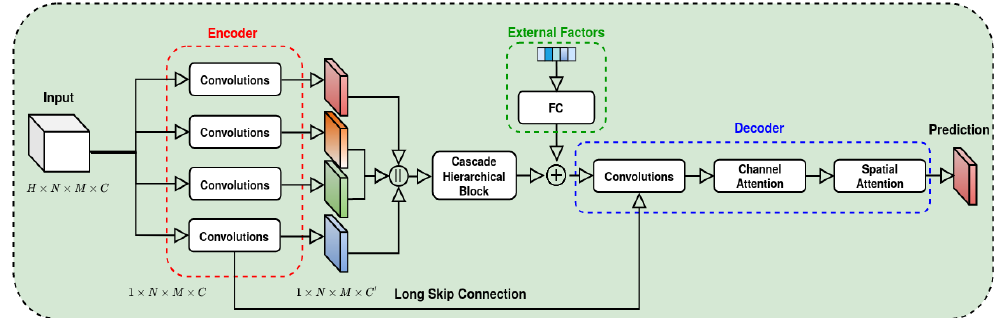
Figure 2. STREED-Net Architecture.